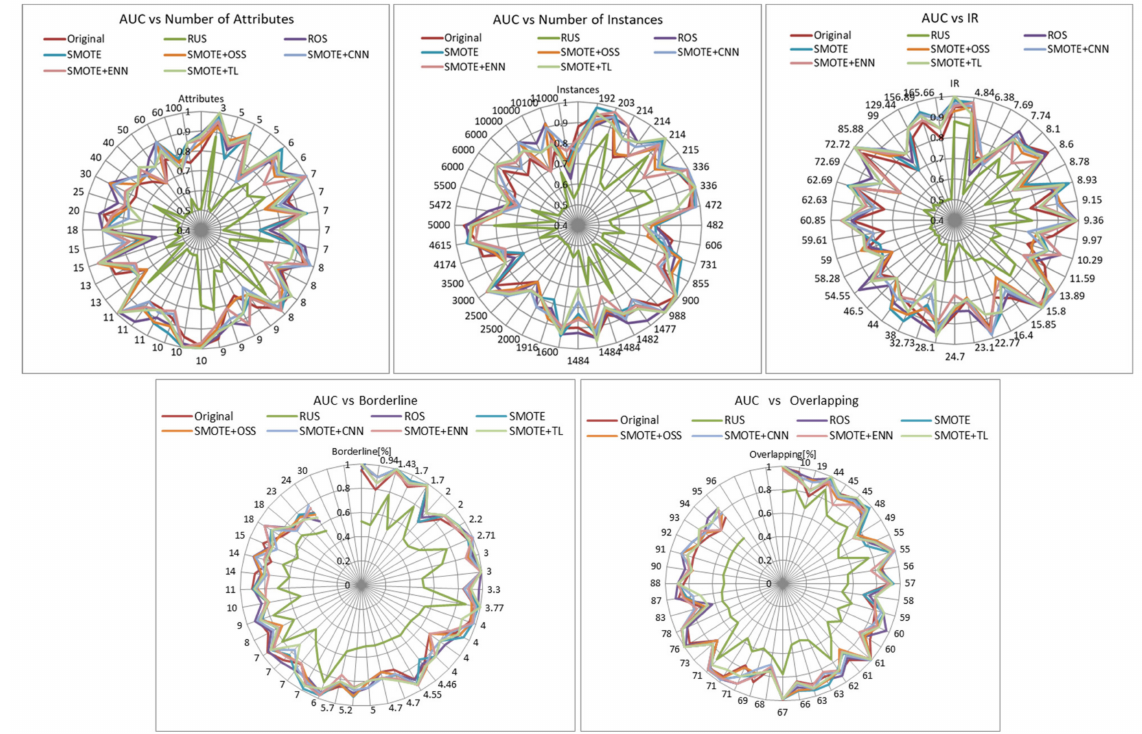
Figure 2. Influence of dataset characteristics on AUC for all resampling